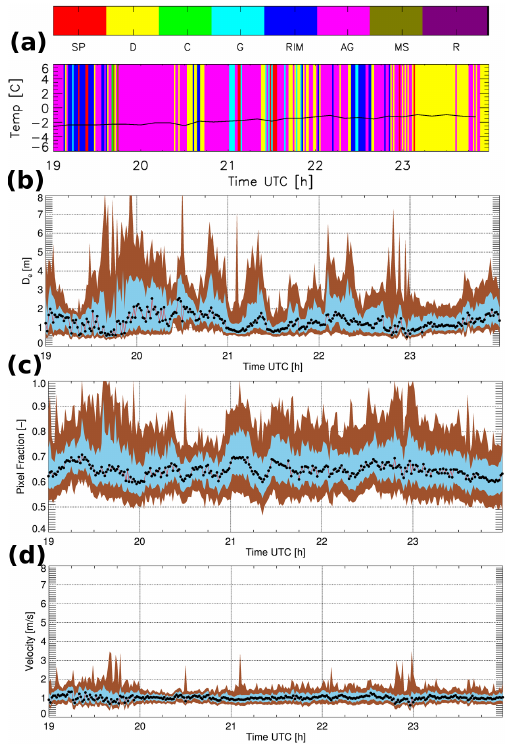
Figure 10. As in Fig. 9 but for 12 January